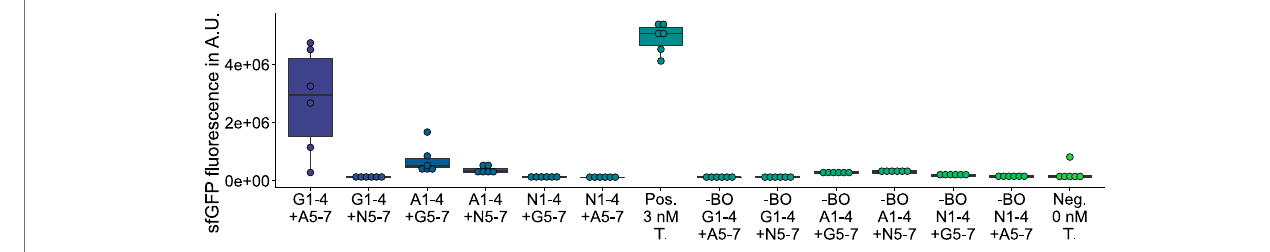
FIGURE3| GFPmeasurementsofassemblieswithhybridsequences.G n :sfGFPfragment n ;A n :mAvicFP1fragment n ;N n :mNeonGreenfragment n ;Pos.:3 nM of the template plasmid used to obtain the vector for assembly; -BO: no bridging oligos added; Neg.: No Template DNA added.